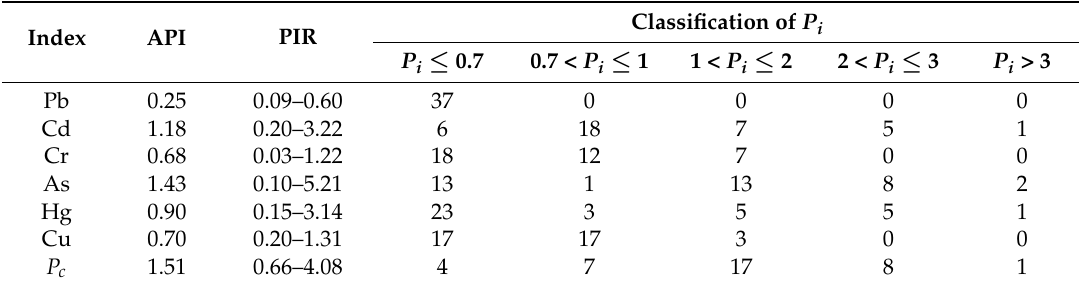
Table 6. Pollution status of P. notoginseng cultivation soil ( n =